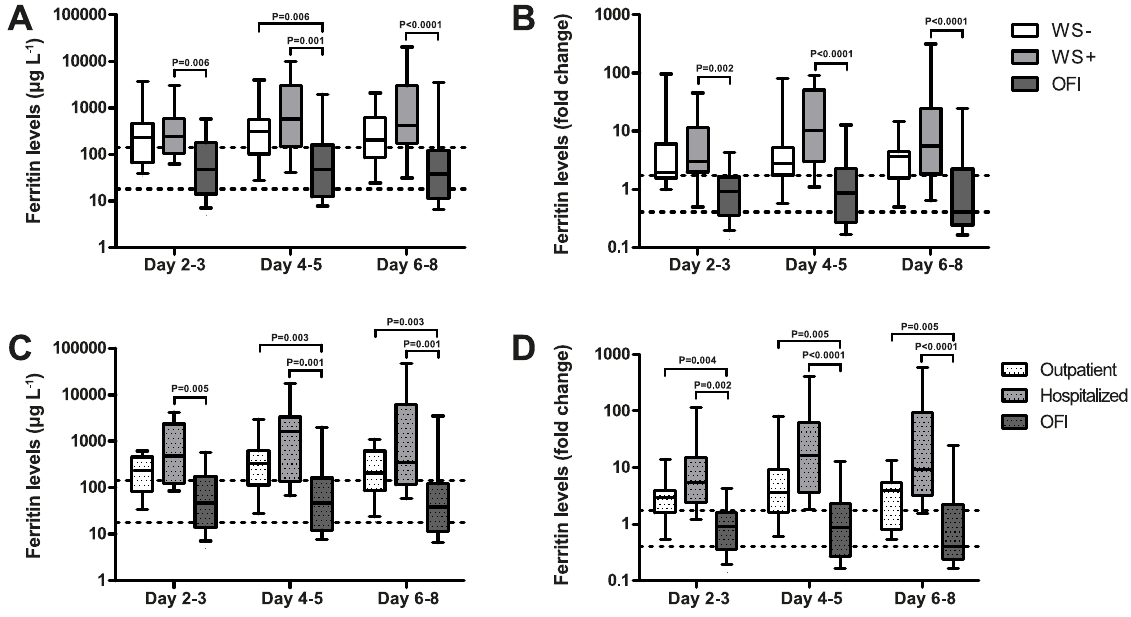
Figure 1. Ferritin levels and fold change are increased in dengue patients from Aruba. Absolute levels of ferritin were significantly increased in WS + patients compared to OFI at each time point and in WS 2 patients compared to OFI at day 4–5 (A). Absolute levels were also elevated in hospitalized and outpatients compared to OFI (C) at almost each time point. The ferritin fold change was significantly elevated in WS + patients compared to OFI (B) and in hospitalized and outpatients compared to OFI (D) at each time point. Area between two dotted horizontal lines: interquartile range from the autologous control group. Boxplots indicate the interquartile range, the horizontal line inside the box indicates the median. The whiskers reach from the 10 th till the 90 th percentile. P-value # 0.006 is considered significant.